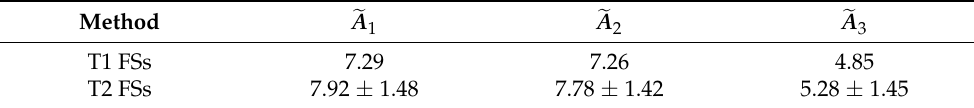
Figure 7. Comparison results of the evaluation method based on T1 FSs and the method of this study: ( a ) Overall ratings obtained by the evaluation method based on T1 FSs; ( b ) Overall ratings obtained by the method of this study. Table 7. Teaching performance rankings given by the evaluation method based on T1 FSs and the method of this